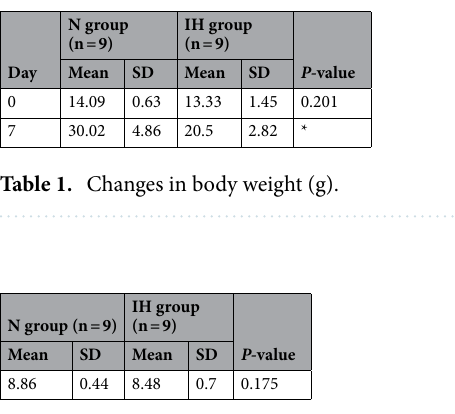
Table 2. Comparison of tibial length (mm) between the N and IH groups at day 7.